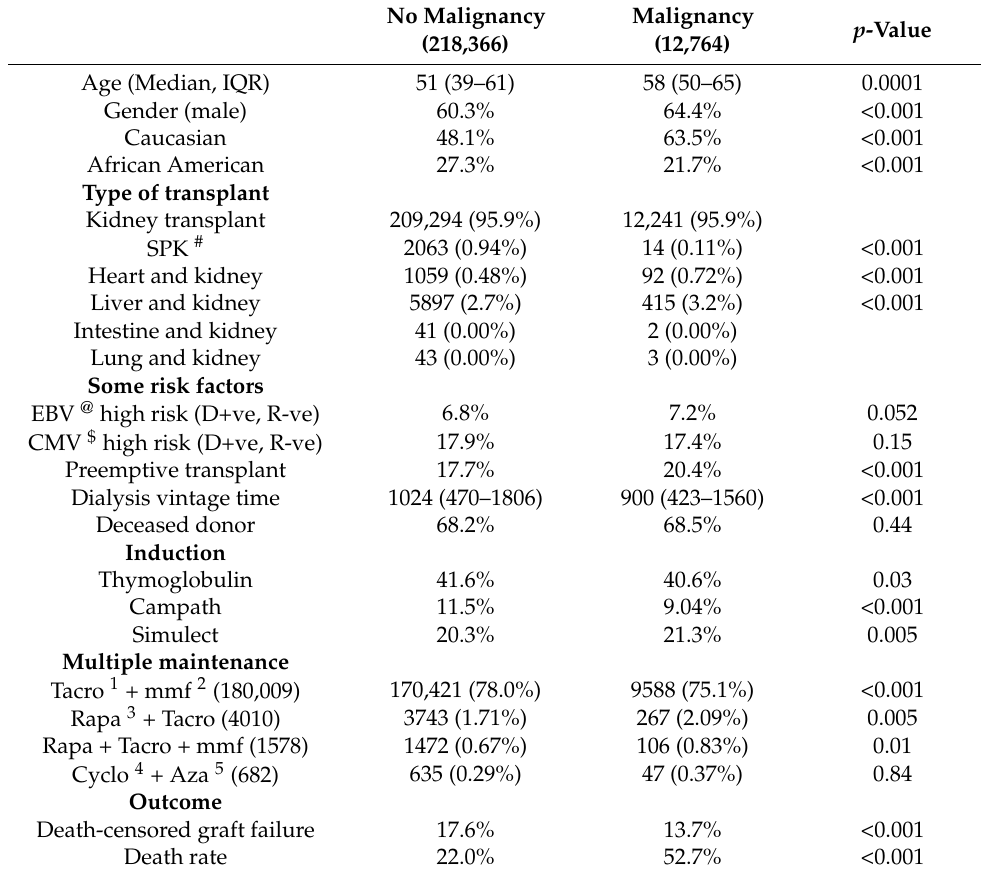
Table 1. General comparison of the